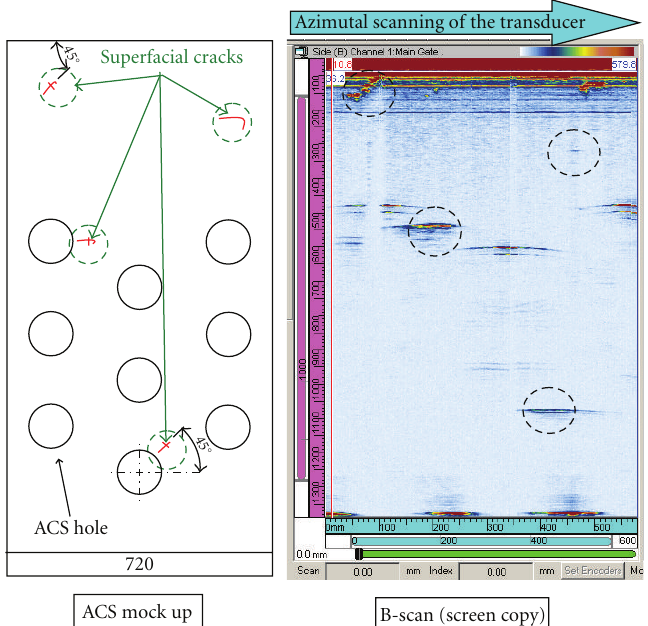
Figure 25: Surface ultrasonic controls of thermal striping cracks. Echoes are due to geometrical boundaries (holes) and to superficial cracks.